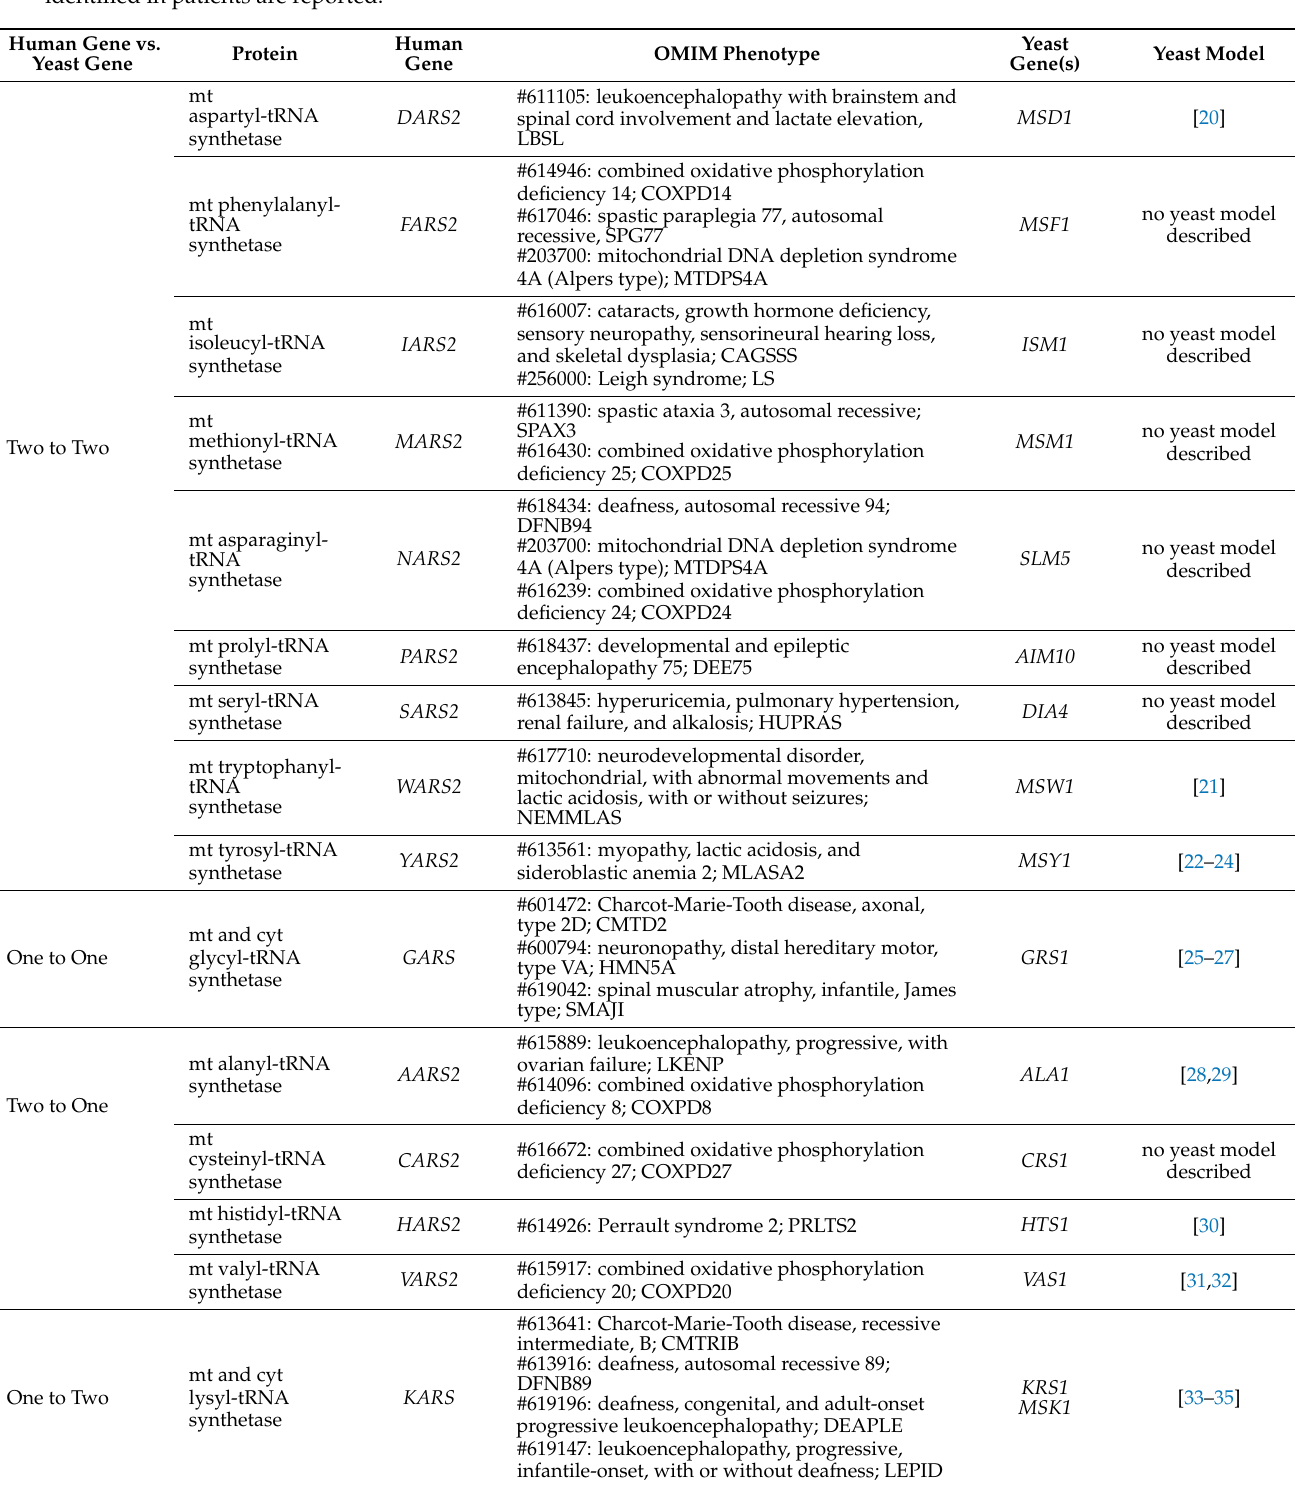
Table 2. List of human mt ARS genes and their corresponding yeast orthologues. For each gene, the associated human diseases with OMIM number and the publications where yeast was used to validate the pathogenic role of the variants identified in patients are